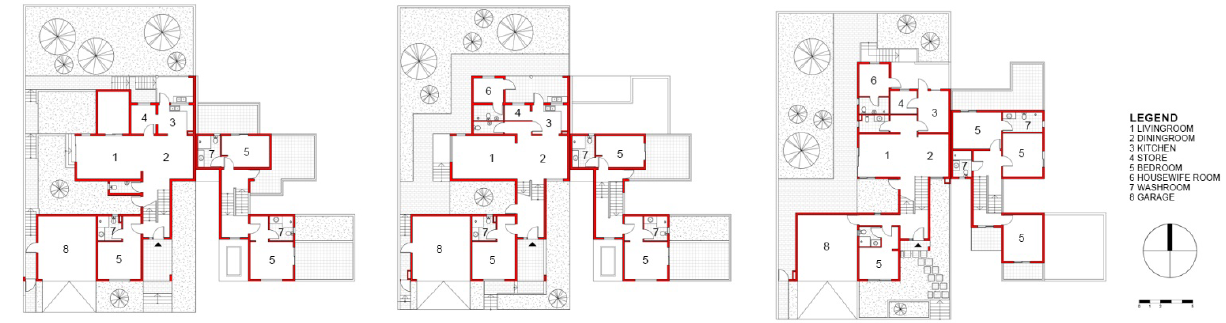
Figure 53. The Umudugudu Kigali Vision: Ground and first floor twin houses (3-4 Bedrooms). Drawing by Manlio Michieletto.